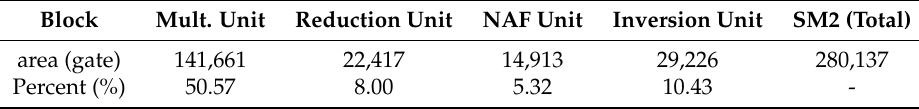
Table 2. Hardware consumption of each block on ASIC